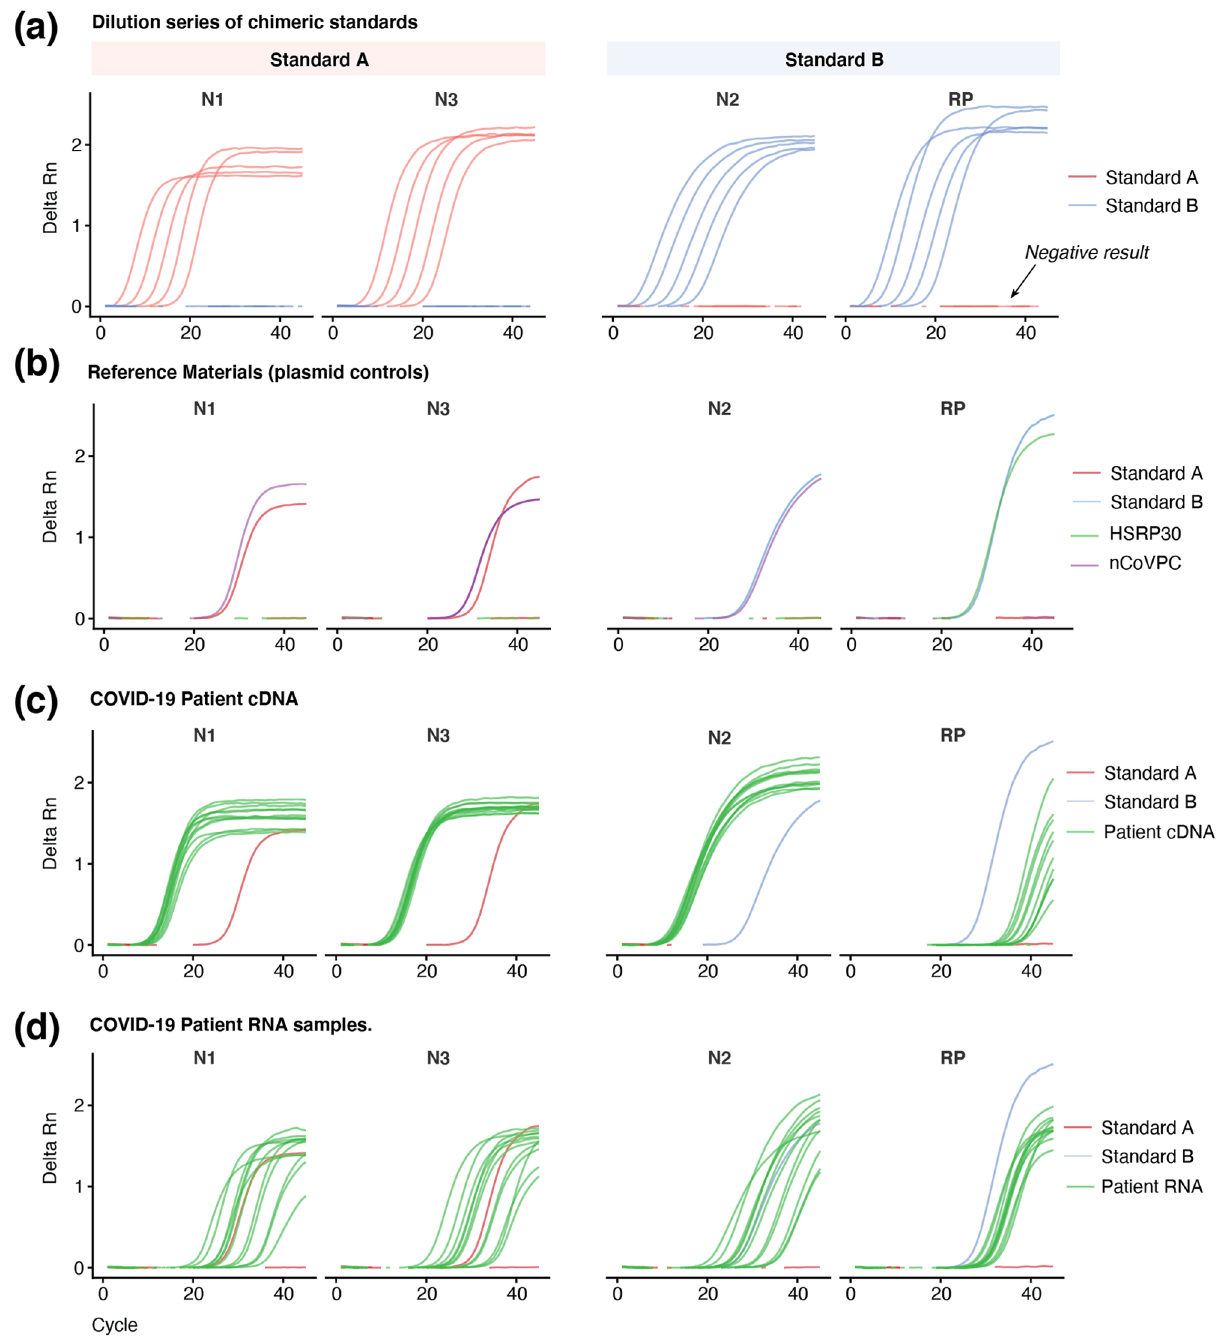
Figure 2. Real-time RT-PCR validation of chimeric A/B sandards. Amplification curves for genes targeted in the CDC real-time RT-PCR test for SARS-CoV-2 (N1, N2, N3 and RP). ( a ) Dilution series showing amplification curves for standards A (red line) and B (blue line). ( b ) Amplification curves comparing the chimeric A/B standards with IDT positive (nCoVPC, purple line) and negative controls (HSRP30, green line). ( c , d ) Amplification curves comparing the chimeric A/B standards with positive COVID-19 cDNA and RNA patient samples (green line, n =